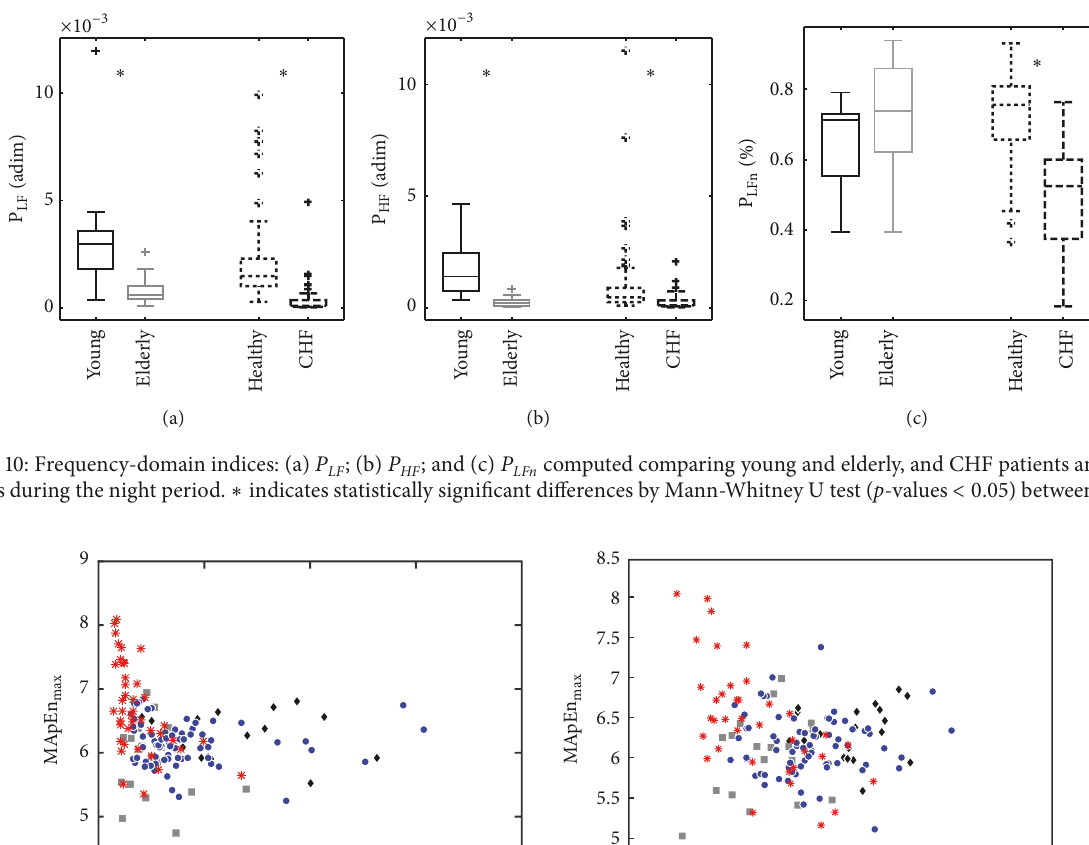
Figure 11: Scatter plots showing the relationship between 𝑀𝐴𝑝𝐸𝑛 𝑚𝑎𝑥 and RMSSD (a) and between 𝑀𝐴𝑝𝐸𝑛 𝑚𝑎𝑥 and P